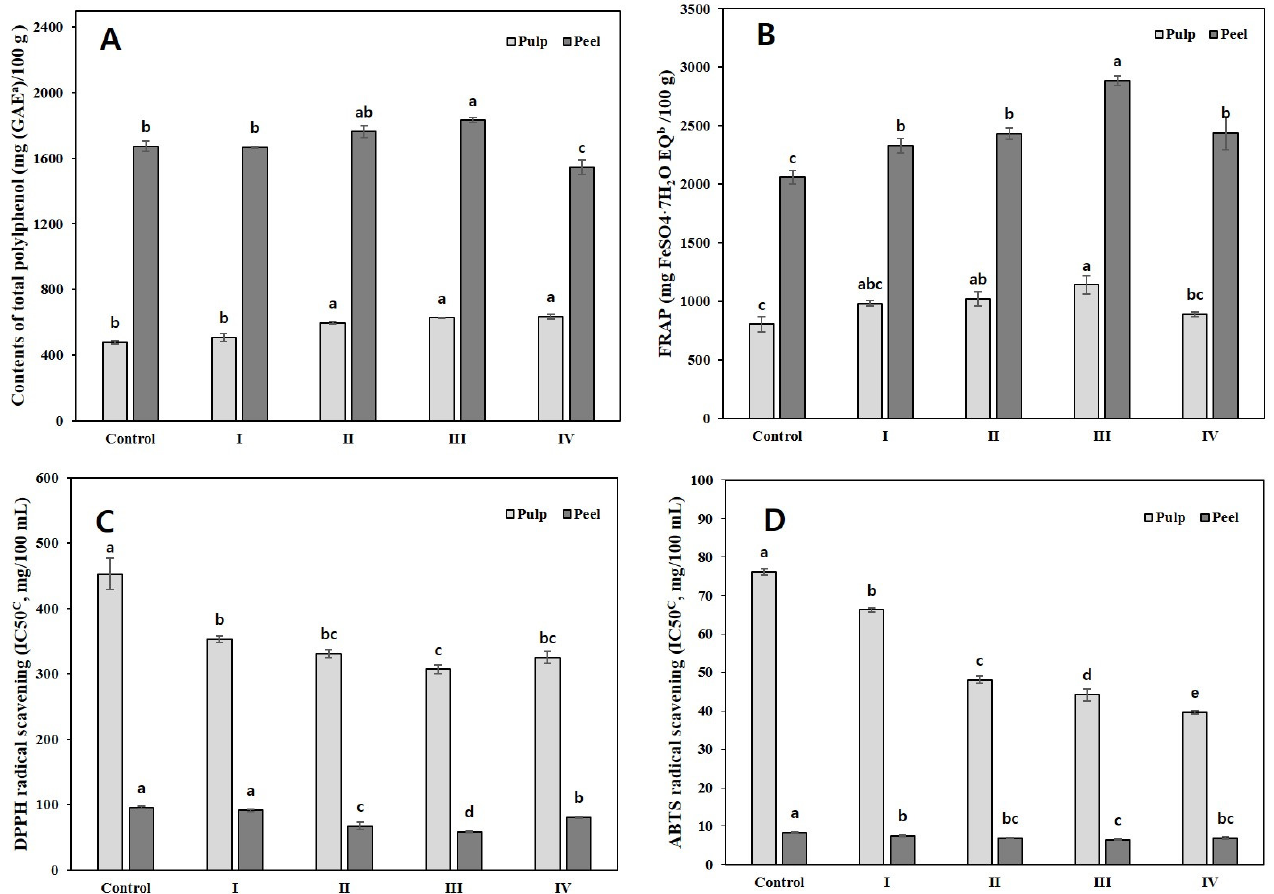
Figure 5. Total polyphenol contents and antioxidant activities according to the degree of sunburn in Satsuma mandarin fruits. ( A ) Total polyphenol contents (TPC); ( B ) Ferric reducing antioxidant power (FRAP); ( C ) 1,1-diphenyl-2-picrylhydrazyl (DPPH) radical scavenging activity; ( D ) 2,2 ′ -az- inobis (3-ethylbenzothiazoline-6-sulfonic acid (ABTS) radical scavenging activity. a TPC values are expressed as mg of gallic acid equivalents (GAE) per 100 g of 70% ethanol extracts. b FRAP values are expressed as mg of Iron (II) sulfate heptahydrate (F 2 SO 4· 7H 2 O) equivalents per 100 g of 70% ethanol extracts. c IC50, concentration in mg per 100 mL required for scavenging the DPPH and ABTS radicals by 50%. The data are expressed as mean ± SE ( n = 3). The values representing different letters are statistically significant ( p < 0.05).